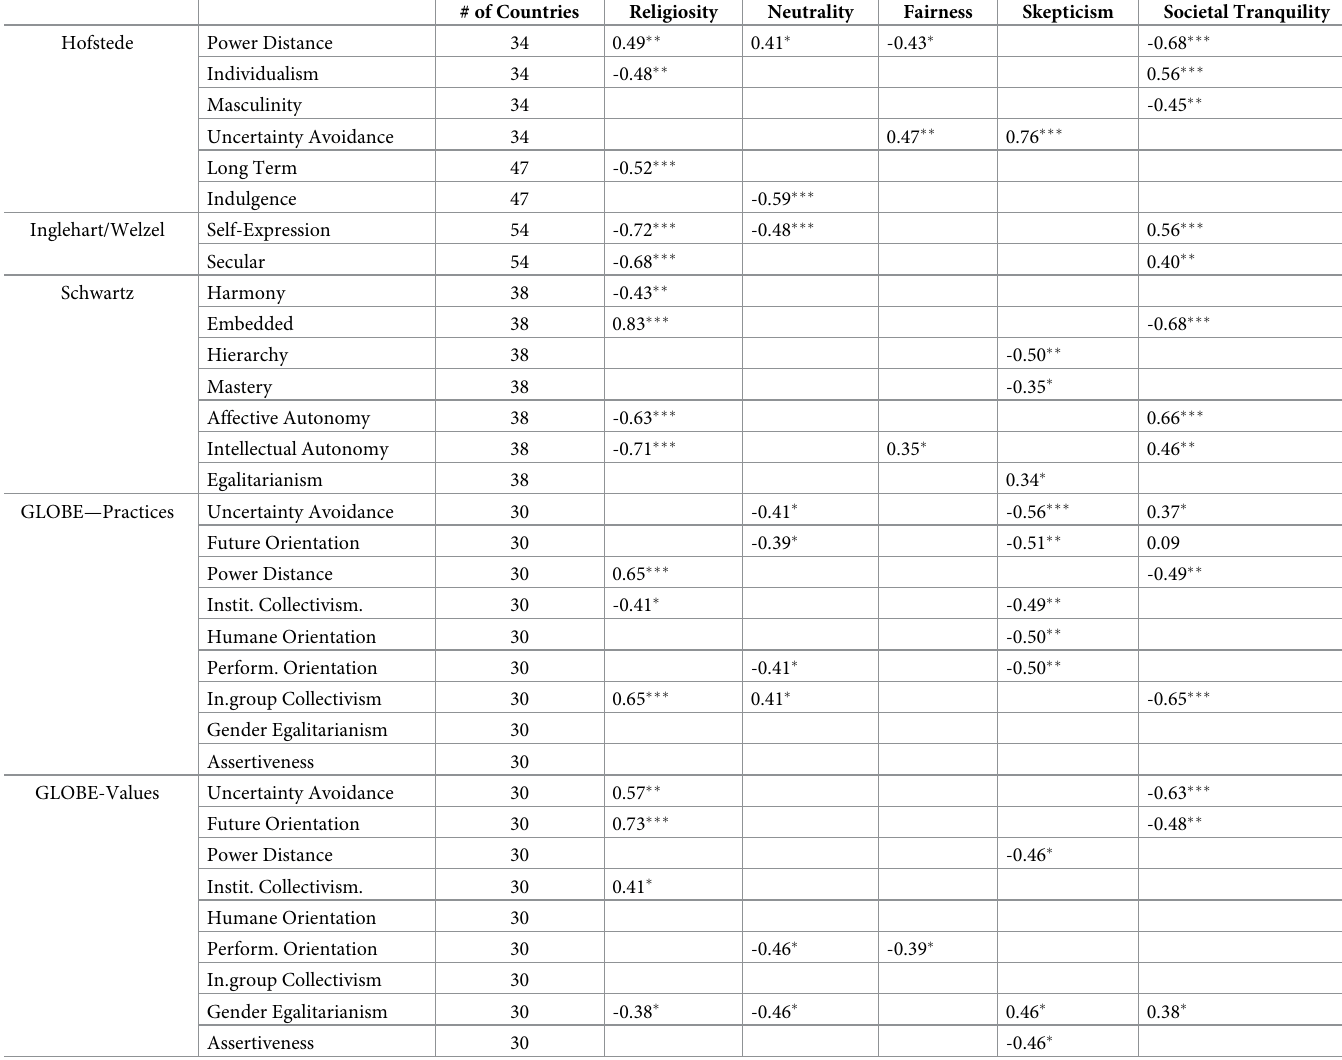
Table 5. Country score correlations with published cultural dimensions